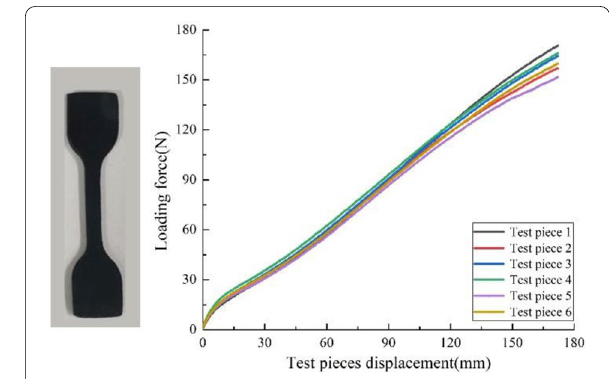
Figure 4 Uniaxial tension test results at 20